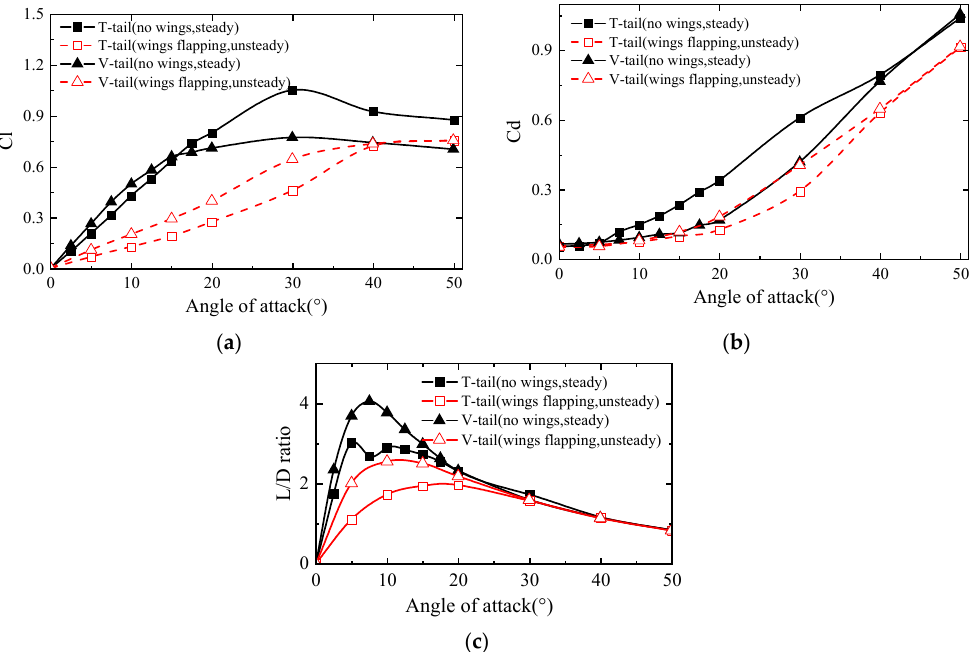
Figure 12. Tails’ force characteristics. ( a ) Lift coefficient curve. ( b ) Drag coefficient curve. ( c ) L/D ratio.